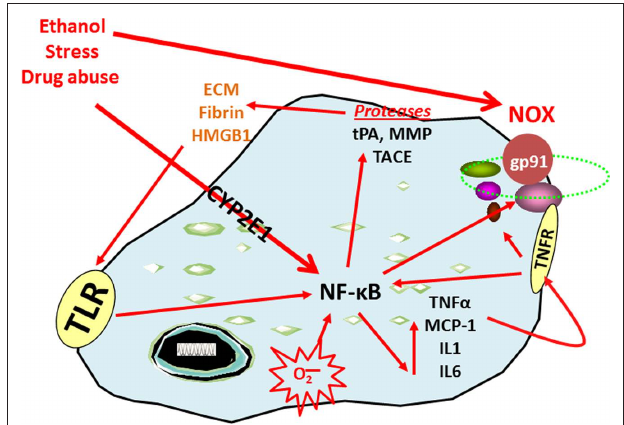
Figure 1 | Nuclear factor kappa-light-chain-enhancer of activated B cells transcription increases the expression of chemokines, cytokines, oxidases, and proteases. The transcription factor NF- κ B is involved in the induction of innate immune genes (Ghosh and Hayden, 2008). Stimuli such as stress, drugs of abuse, peptides, chemokines, cytokines, reactive oxygen species (ROS), ultraviolet irradiation, bacteria, viruses, trauma, and other factors all increase NF- κ B-DNA binding and transcription. Reactive oxygen species resulting from oxidases such as NADPH-oxidase or ethanol metabolism by CYP2E1 increase NF- κ B transcription of NOX2 phox , a key NOX catalytic subunit (Cao et al., 2005) that produces ROS (Qin et al., 2008). Loops of activation also occur through induction of genes that stimulate further NF- κ B activation leading to autocrine and paracrine amplification and persistent signals. Cytokines and chemokines, such as TNF α , IL1 β , IL6, and MCP-1 as well as their receptors (TNFR in figure), are also induced resulting in amplification loops. Toll-like receptors are increased by ethanol (Dolganiuc et al., 2006; Alfonso-Loeches et al., 2010) as are other damage-associated molecular pattern receptors and there agonists resulting in the formation of positive activation loops (Garg et al., 2010). Toll-like receptors and HMGB1 interact to create another activation- amplification loop. Persistent and repeated activation occurs through positive cycles of activation. These loops spread innate immune signaling across the brain causing altered neurocircuitry and neurobiology. Figure abbreviations: CYP2E1, cytochrome P450 2E1; ECM, extracellular matrix; EtOH, ethanol; gp91, NADPH-oxidase flavocytochrome b components; HMGB1, high-mobility group box 1; IL-1 β , interleukin-1 beta; IL1, interleukin-1; LPS, lipopolysaccharide; MMP, matrix metalloproteinase; MCP-1, monocyte chemoattractant protein-1; NOX, nicotinamide adenine dinucleotide phosphate (NADPH) oxidases; NF- κ B, nuclear factor kappa-light-chain-enhancer of activated B cells; TACE, TNF α converting enzyme; TLR, toll-like receptor; TNF α , tissue necrosis factor-alpha; tPA, tissue plasminogen